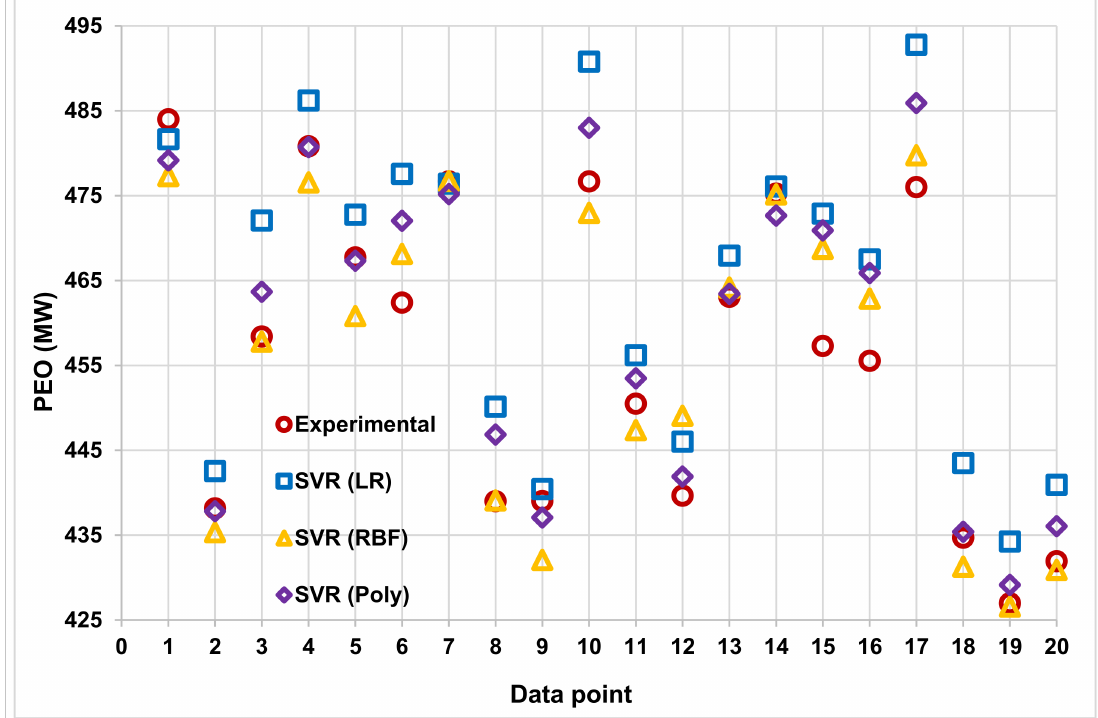
Figure 16. The predicted data of CCPP using SVR (LR), SVR (RBF), and SVR (Poly.) algorithms were obtained after testing in comparison with experimental